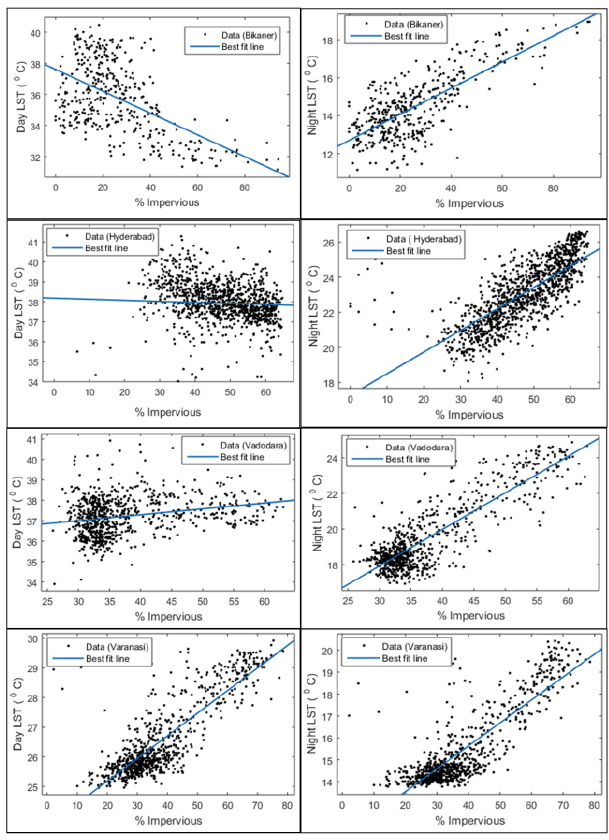
Figure 4. Scatterplot of day and night LST with % Impervious for Bikaner, Hyderabad, Vadodara and Varanasi. City